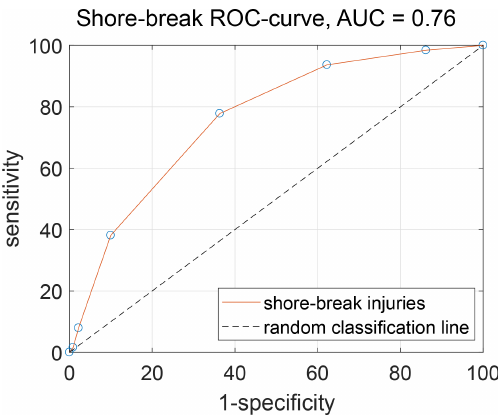
Figure 6. Receiver operating characteristic curve (ROC) of the shore-break BN of one of the fold